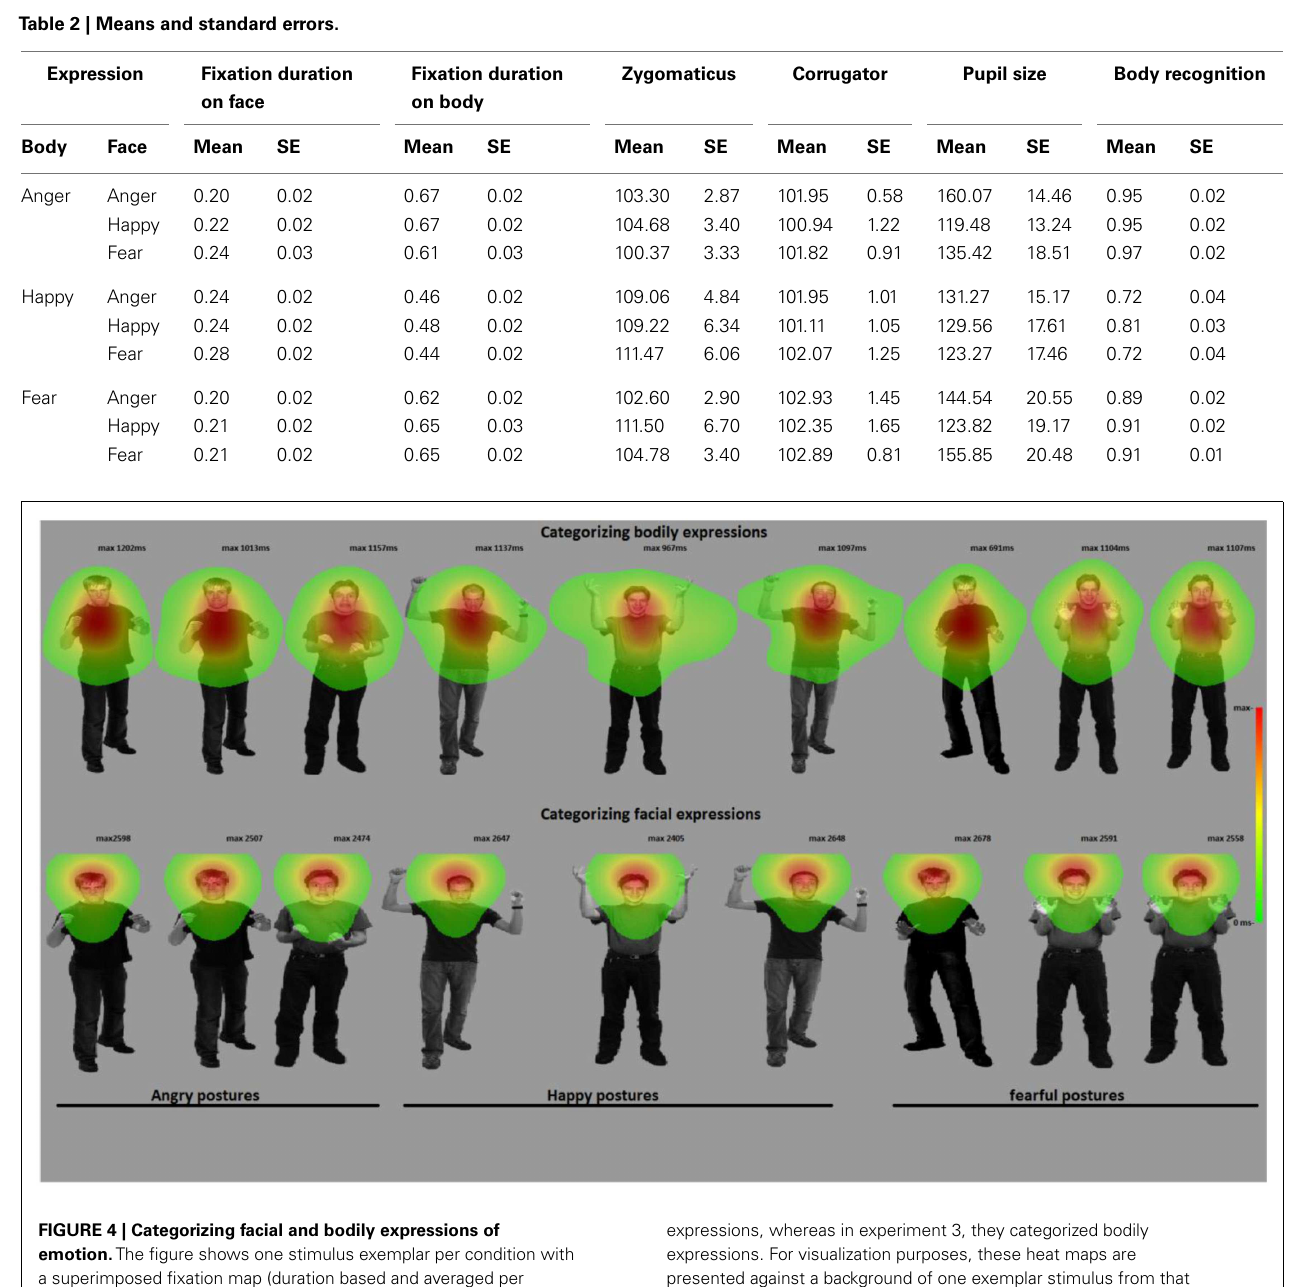
FIGURE 4 | Categorizing facial and bodily expressions of emotion. The figure shows one stimulus exemplar per condition with a superimposed fixation map (duration based and averaged per condition). In experiment 2, participants categorized facial